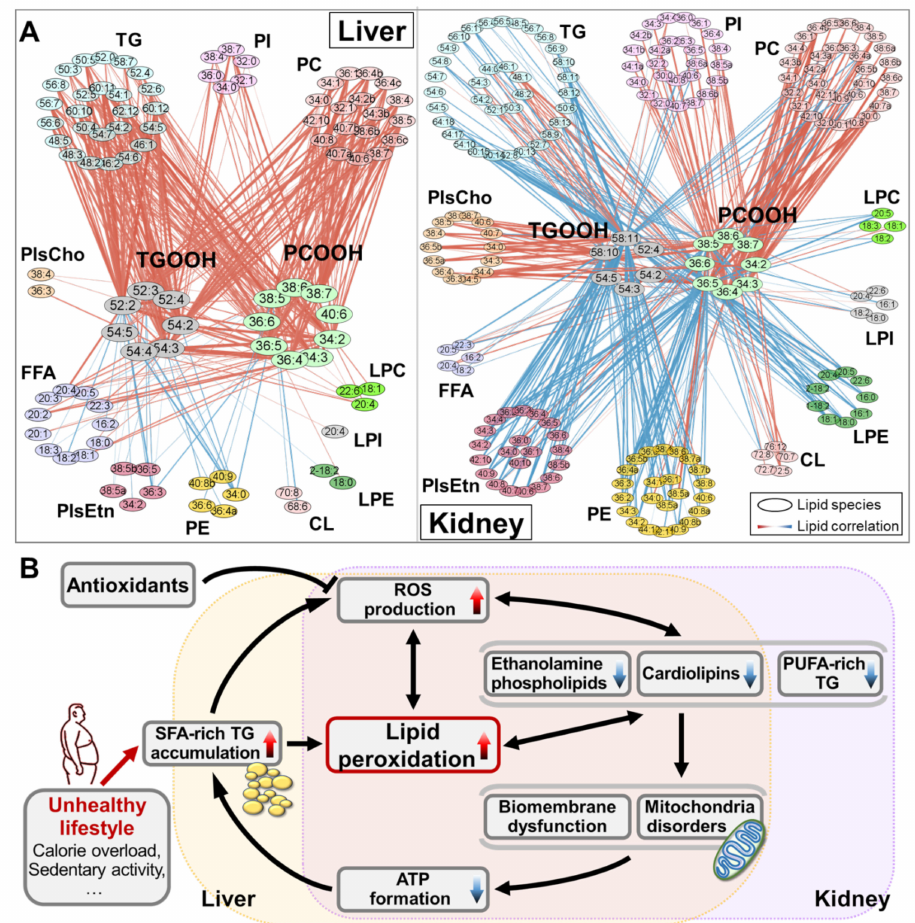
Figure 7. ( A ) Visualized connective network of PCOOH, TGOOH, and intact lipid species in the liver (left) and the kidney (right) of the NASH model mice. The colors of the nodes represent different lipid classes, and the color and width of the lines connecting two lipid species correspond to their dependency as Pearson’s coefficient of correlation. ( B ) Putative process of the “vicious circle” for oxidative stress associated with lipid dysregulation in